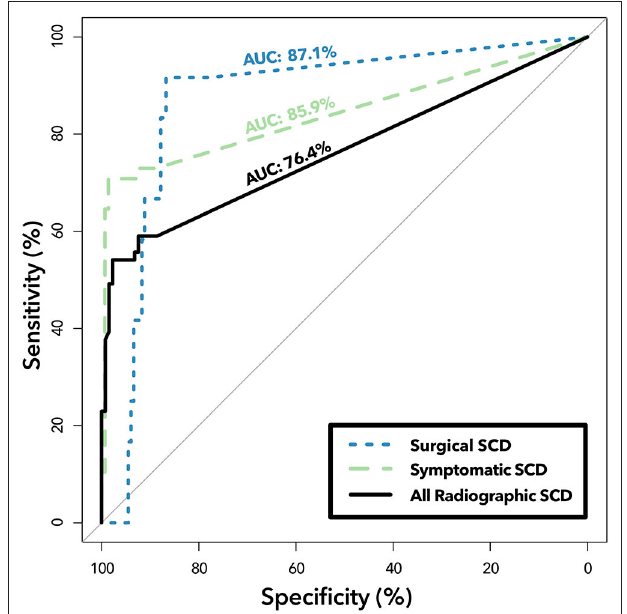
FIGURE 5 | ROC analysis of 4kHz oVEMP amplitude in detecting subgroups of SCD. Receiver operating characteristic curves demonstrating diagnostic ability of 4kHz oVEMP amplitude in classifying all cases of radiographic dehiscence (“All Radiographic SCD,” solid line), only symptomatic cases with radiographic dehiscence (“Symptomatic SCD,” dashed line), and surgically repaired cases of SCD (“Surgical SCD,” dotted line). Area under the curve (AUC) quantifies the accuracy for classifying Surgical SCD (top), Symptomatic SCD (middle) and All Radiographic SCD (bottom). The difference between the “All Radiographic SCD” group and the “Symptomatic SCD” group is that patients that have radiographic SCD but without characteristic symptoms are removed from the latter, which improves 4kHz oVEMP detection